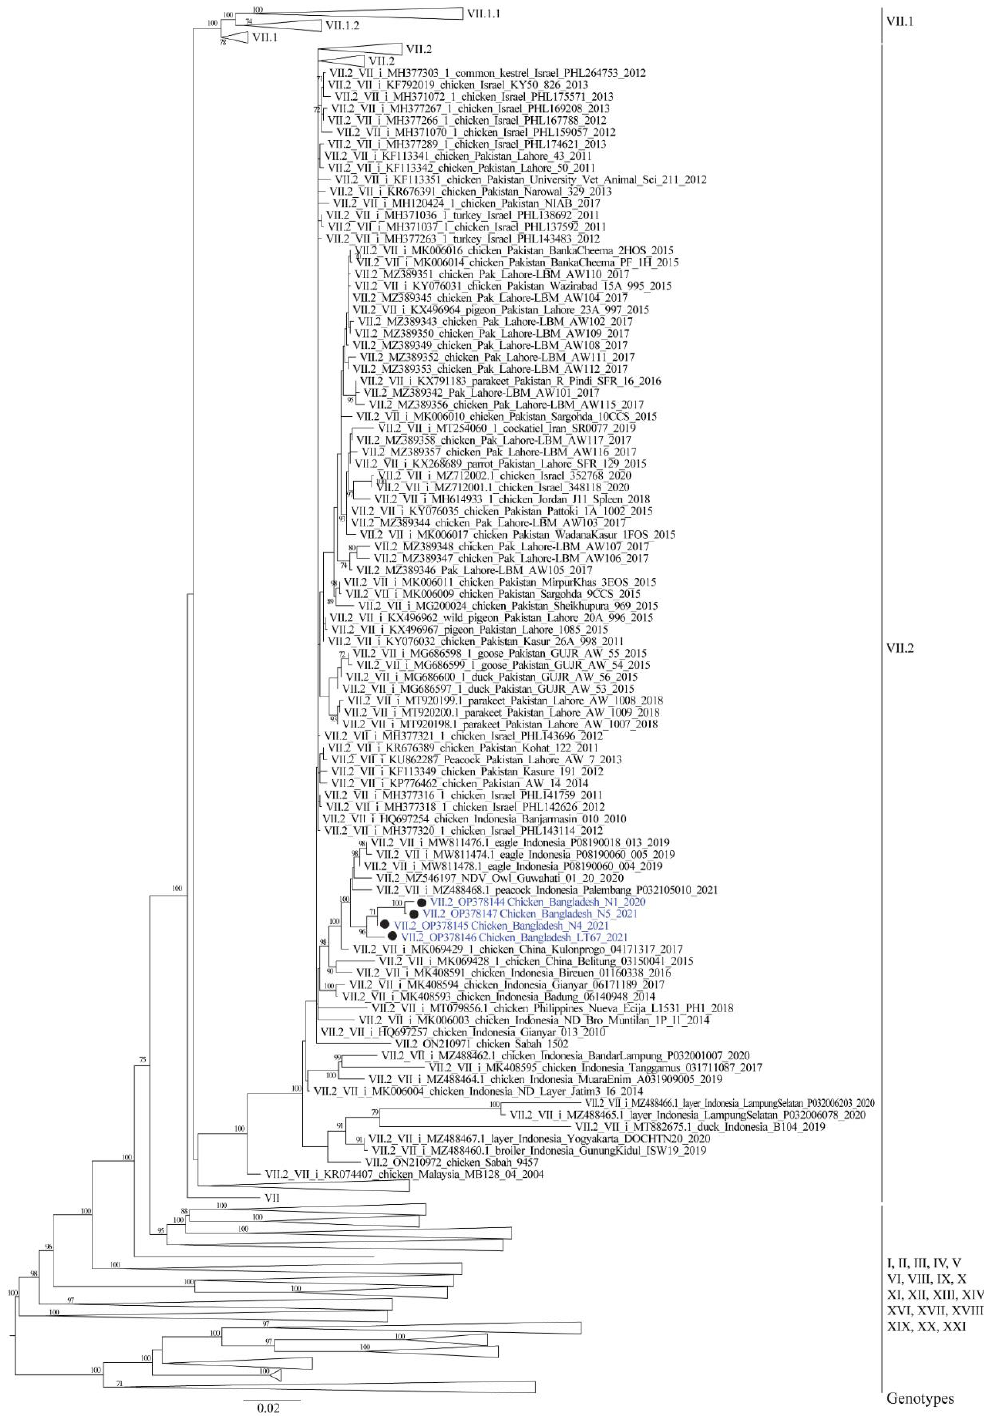
Figure 1. Phylogenetic analysis based on full-length nucleotide sequence of the fusion gene of Newcastle disease virus class II isolates ( n = 2257). The evolutionary history was inferred by using RaxML [34] and utilizing the maximum likelihood method based on the general time-reversible model with 1000 bootstrap replicates. A discrete gamma distribution was used to model evolutionary rate differences among sites and the rate variation model allowed for some sites to be evolutionarily invariable. The tree is drawn to scale, with branch lengths measured in the number of substitutions per site. Bangladeshi isolates of present study are highlighted using filled circle ( • ). There were a total of 1653 positions in the final dataset. Only bootstrap values above 70 are